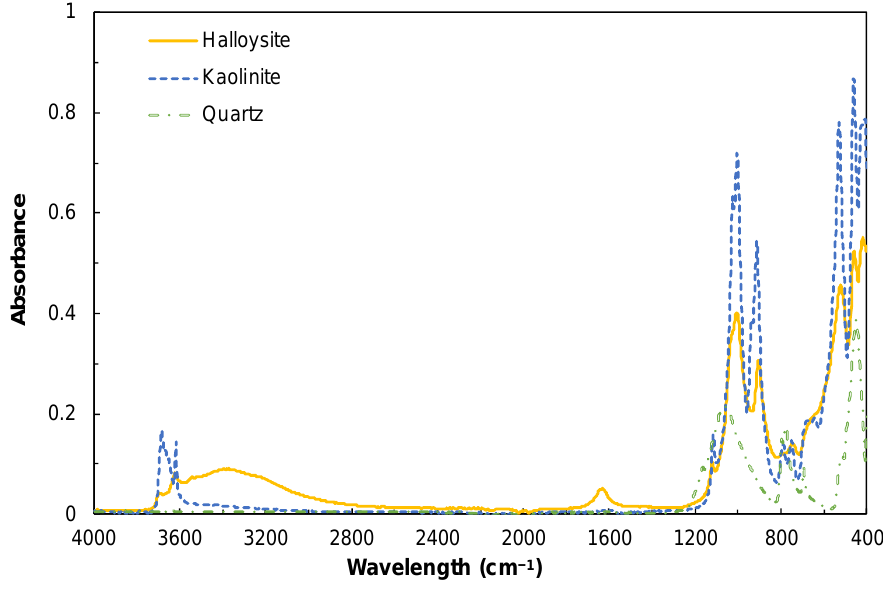
Figure 4. FTIR spectra of halloysite, kaolinite, and quartz minerals. The fingerprint region of infrared bands related to quartz crystals was between 400–1200 cm − 1 [29]. The characteristic peaks of pure quartz mineral at 1083 cm − 1 and 775 cm − 1 showed asymmetric and symmetrical Si-O stretching vibrations, respectively, and the peak at 450 cm − 1 showed asymmetric Si-O bending vibrations [30].